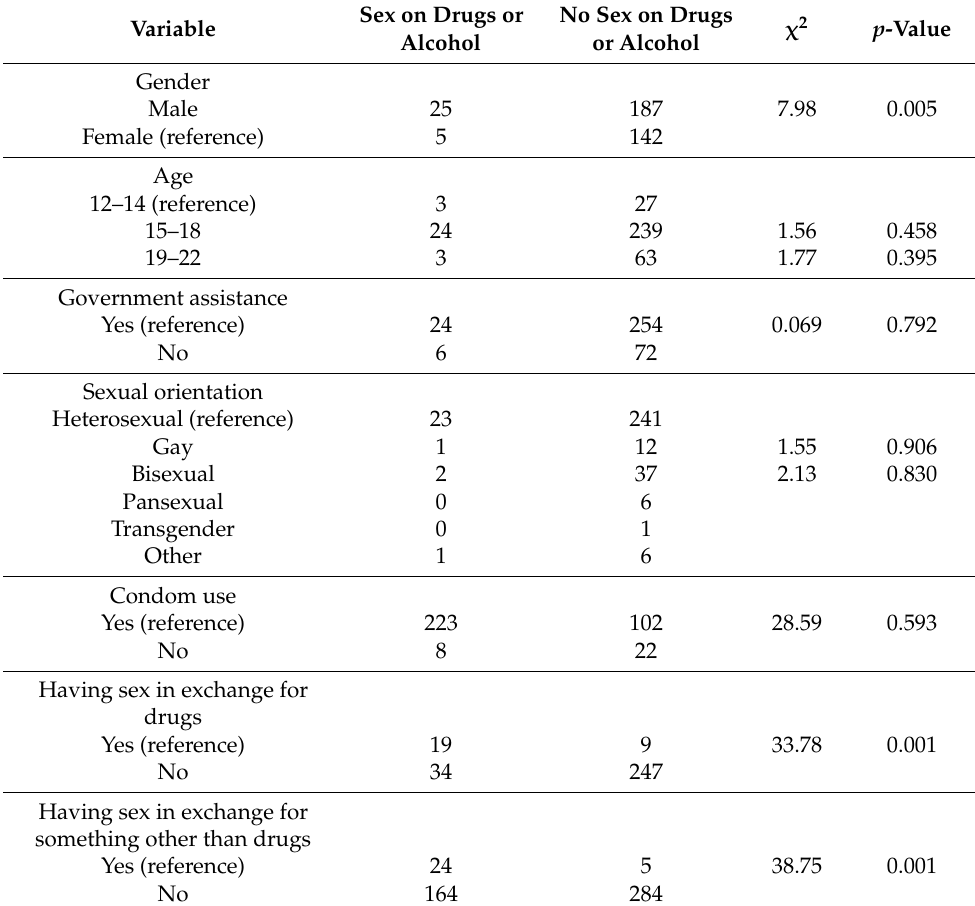
Table 3. Comparison of Chi-square test between sex while on drugs or alcohol and sociocultural variables. Variable